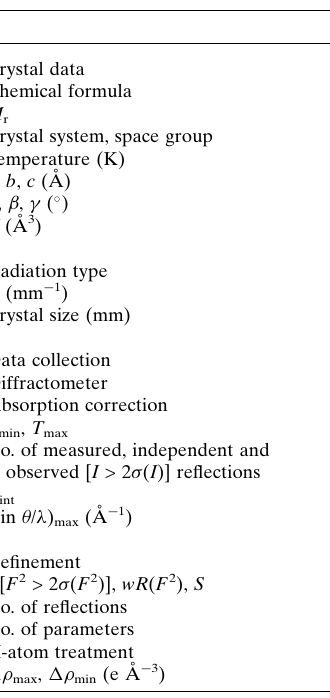
Table 3 Experimental details.